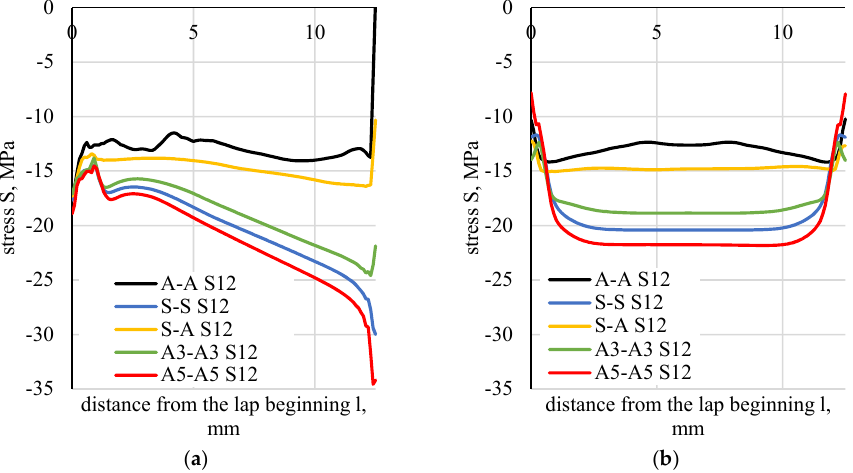
Figure 25. Distributions of normal stresses (S22) perpendicular to the direction of tension: ( a ) in the boundary element–adhesive layer, ( b ) half length of the adhesive thickness.